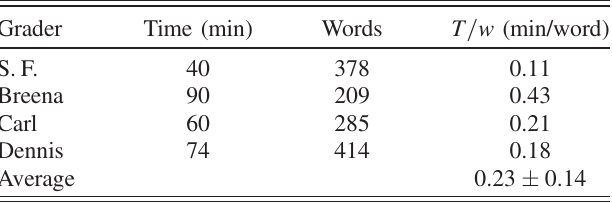
grading time, the number of words in their feedback, and the ratio T=w along with the average ratio T=w .